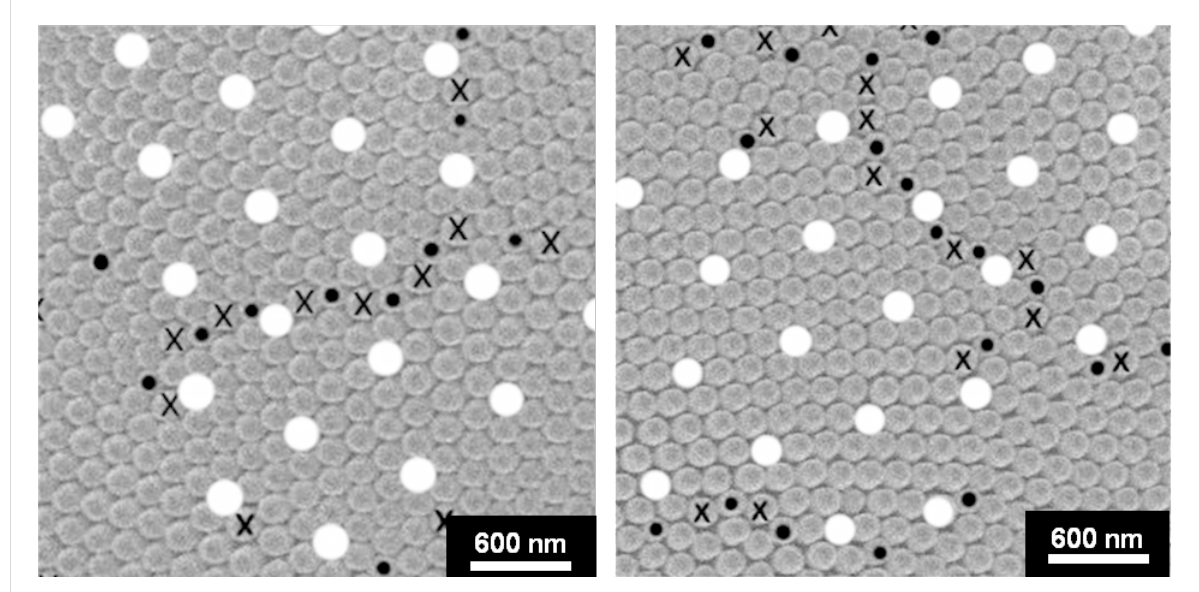
Figure 4: Examples of Σ 13 grain boundaries between crystals (domains) in the nipple structure consisting of rows of 5–7 coordination-defects. White circles indicate nipple positions belonging to a coincidence site lattice (CSL) superlattice (magnification: 20,000×).